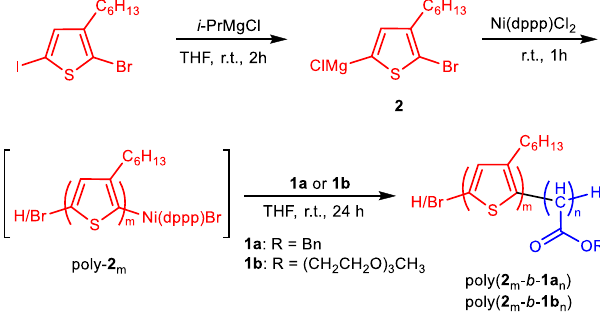
Fig. 5 Synthesis of P3HT- b -polycarbene copolymer. Synthetic route for poly( 2 m - b - 1a n ) and poly( 2 m - b - 1b n ) copolymers.